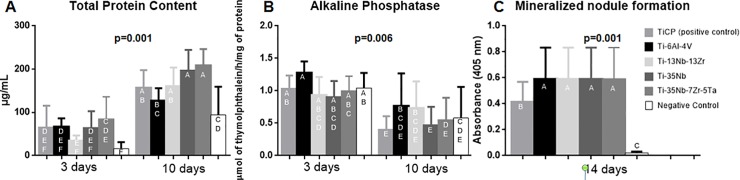
Graphics of data showed effect of sample and periods in different analyses.a) total protein contend; b) ALP; c) mineralized matrix.